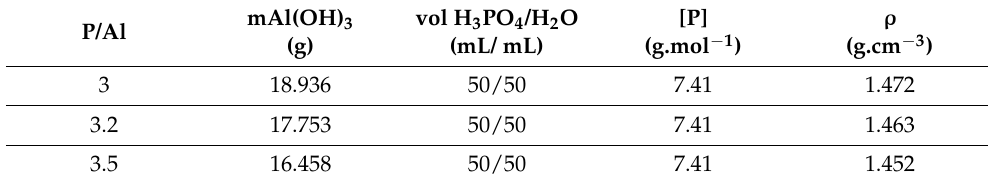
Table 3. Solution preparation parameters (mass of Al(OH) 3 , volumes of H 3 PO 4 and H 2 O, concentra- tion of P ([P])) and density ( ρ ). The error on the density is +/ −